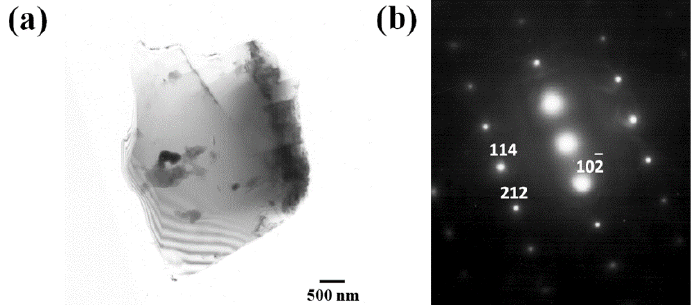
(cid:2) (cid:3) 111 .